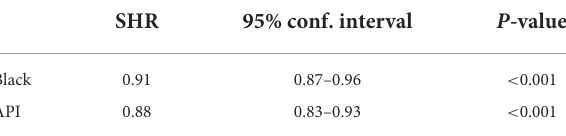
TABLE 4 Sub-distribution hazard ratio of developing second primaries after a bladder cancer diagnosis among the different races; White cases are the